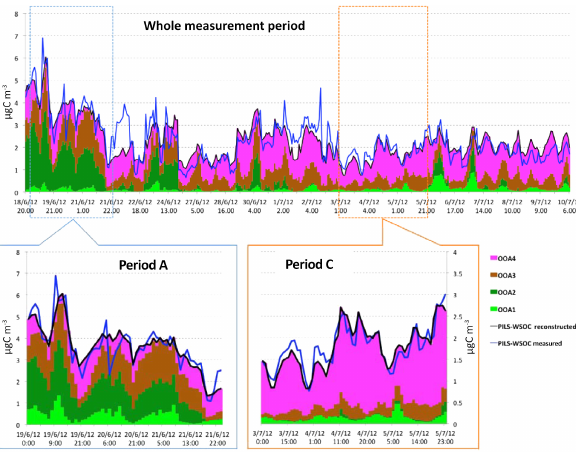
Figure 11. Time series of hourly averaged AMS ME-2 OOA fac- tors, WSOC measured, and WSOC reconstructed for the whole measurement period (top), Period A (bottom left), and Period C (bottom right) at SPC. The units for each OOA factor have been converted from µgm − 3 to µgCm − 3 using their calculated OM / OC